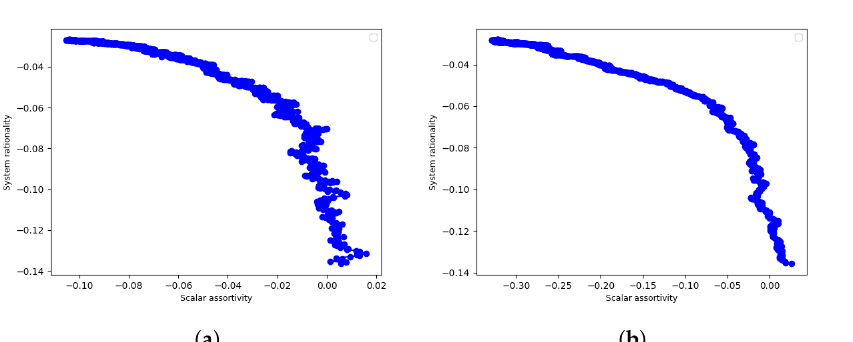
Figure 5. Node rationality-based scalar-assortativity against the number of iterations of node rationality-based preferential rewiring. The scalar disassortativity increases over 2000 iterations whether ( a ) node rationality is positively correlated with node degree or ( b ) node rationality is negatively correlated with node degree.